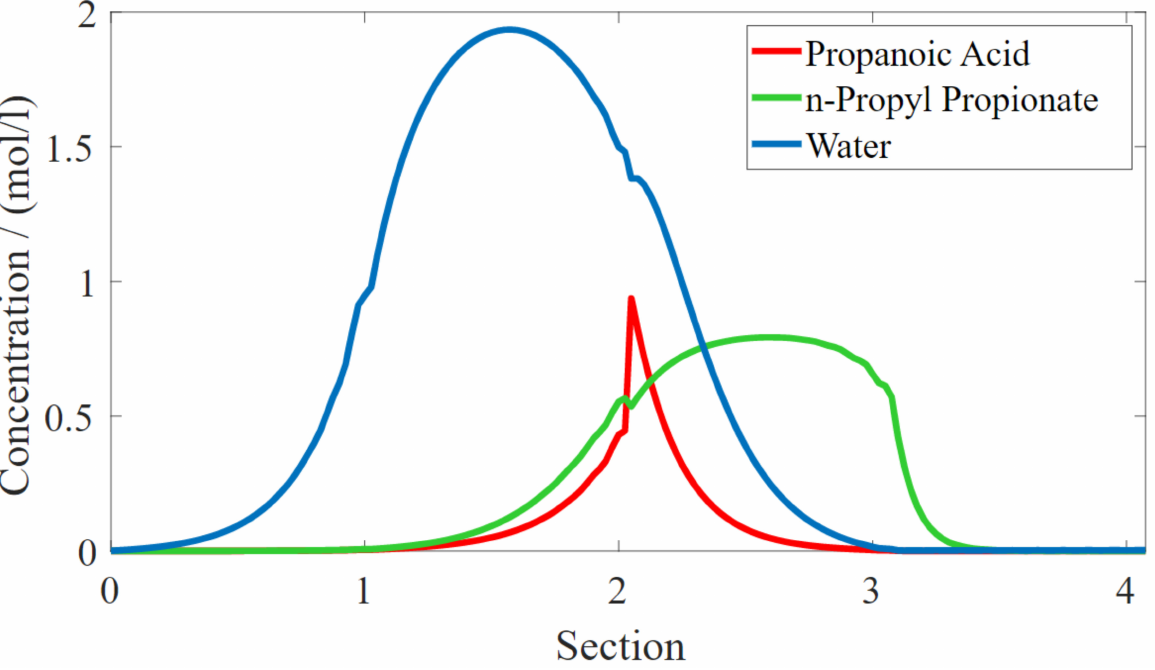
Figure 4. TMBR concentration profile for propanoic acid, n-propyl propionate and water along sections in the cyclic steady